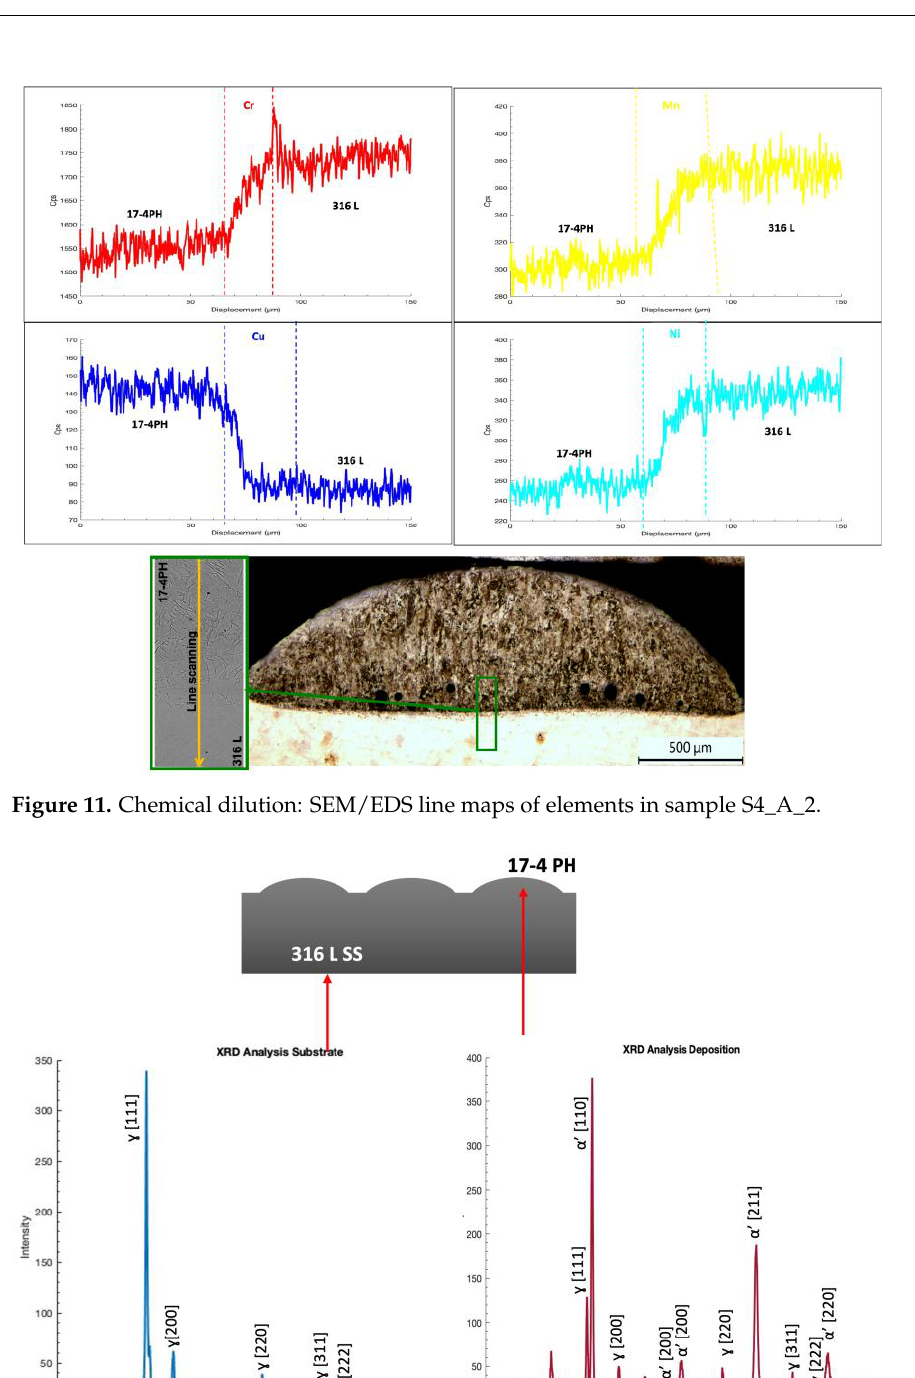
Figure 12. XRD patterns performed on sample S4_A_2.